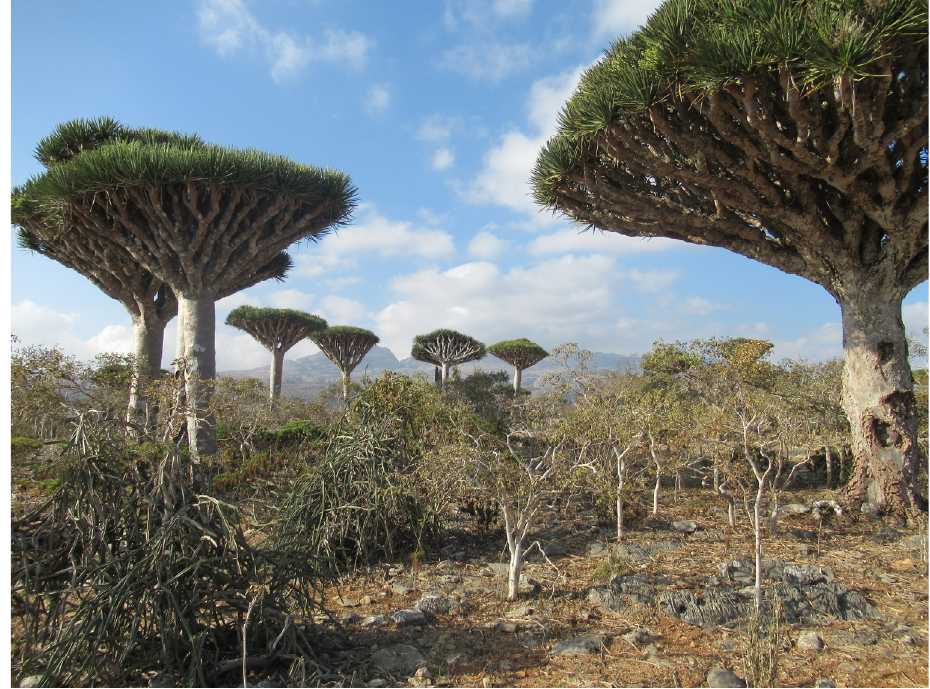
Figure 2. One of the monitoring plots in Firmihin (L. Bauerová, 2021).